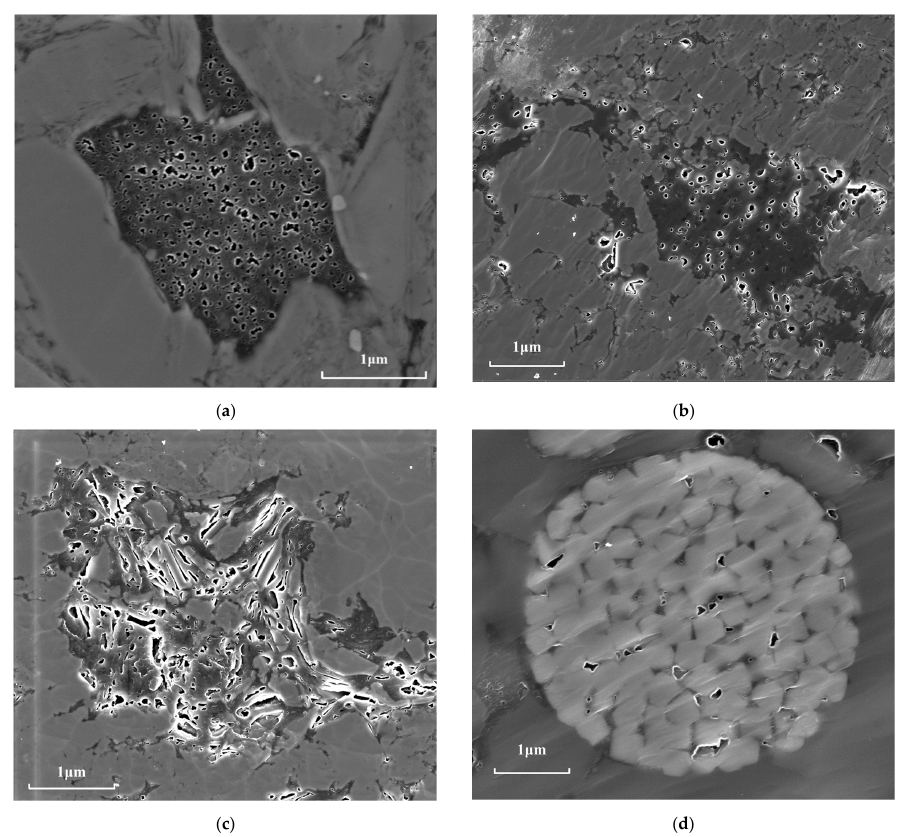
Figure 6. Scanning electron microscope images of organic pores in shale: ( a ) independent organic pores, ( b ) organic pores, ( c ) clay mineral-associated organic pores, and ( d ) pyrite-associated organic pores.